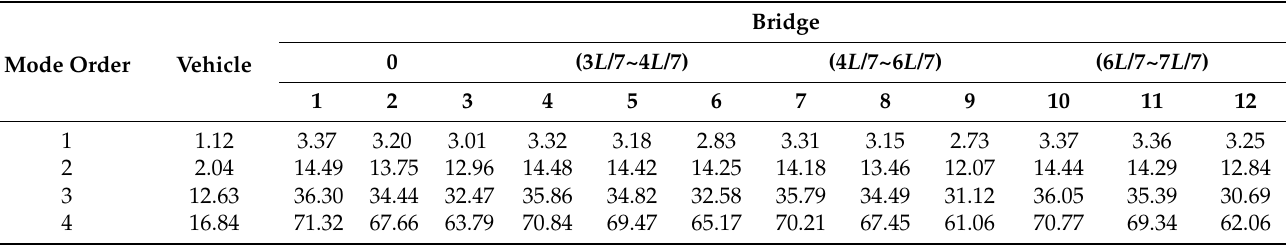
Table 5. The natural frequencies of the vehicle and bridge (Unit: